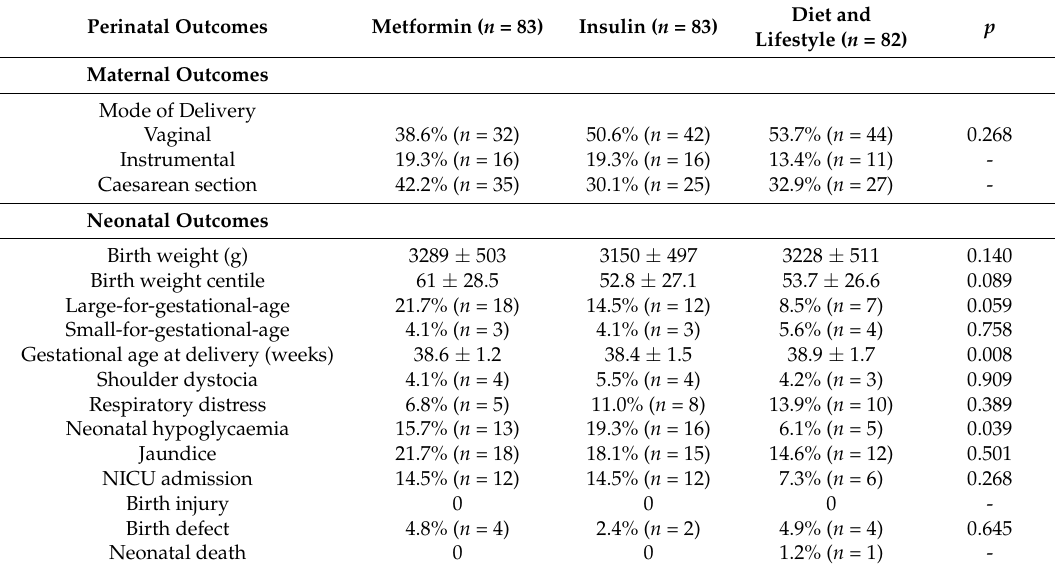
Table 2. Maternal and neonatal outcomes for women receiving metformin in comparison to insulin or diet and lifestyle